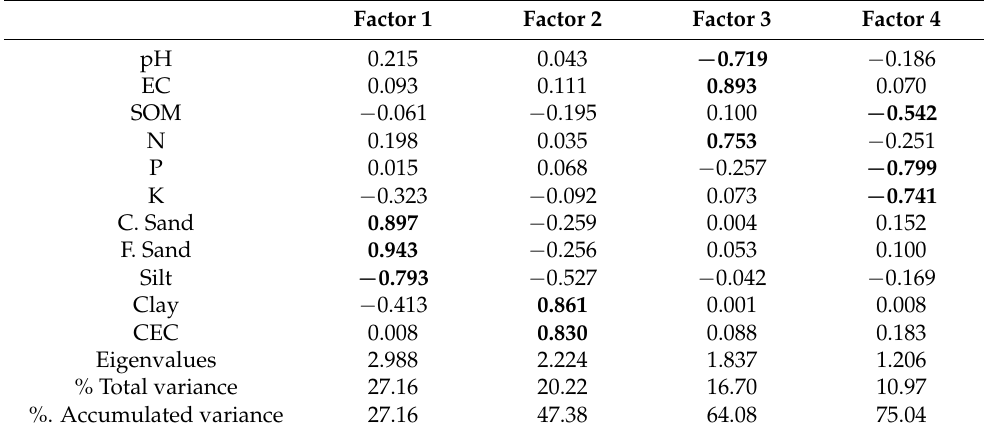
Table 7. Factor loadings, eigenvalues, percentage of total variance, and accumulated variance, in a four-factor model of 11 observed soil variables in the 0–20 cm